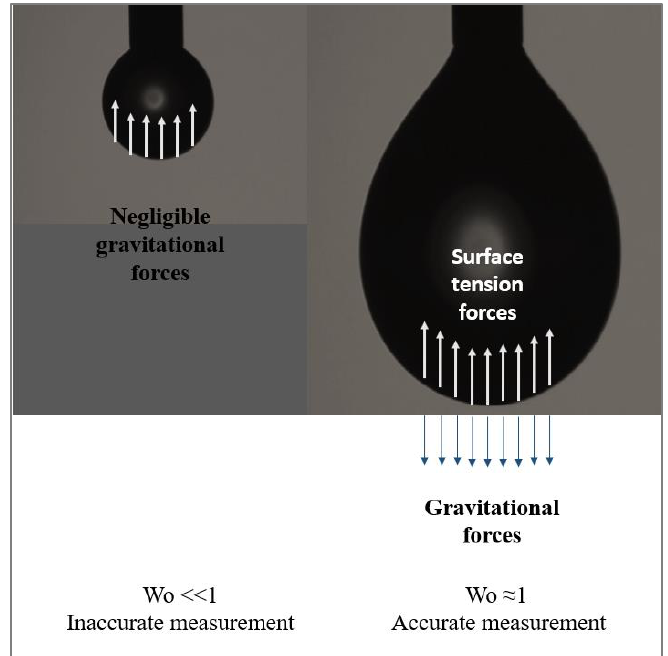
Figure 21. Accuracy of the pendant drop method.